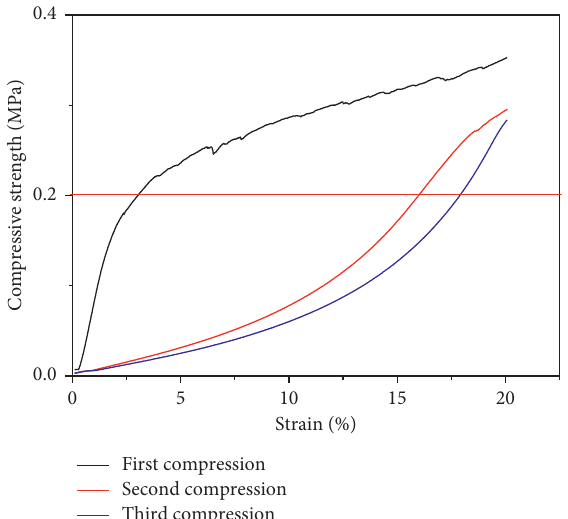
Figure 14: Repeated front compressive strength diagrams of carbon/carbon fiber composites.